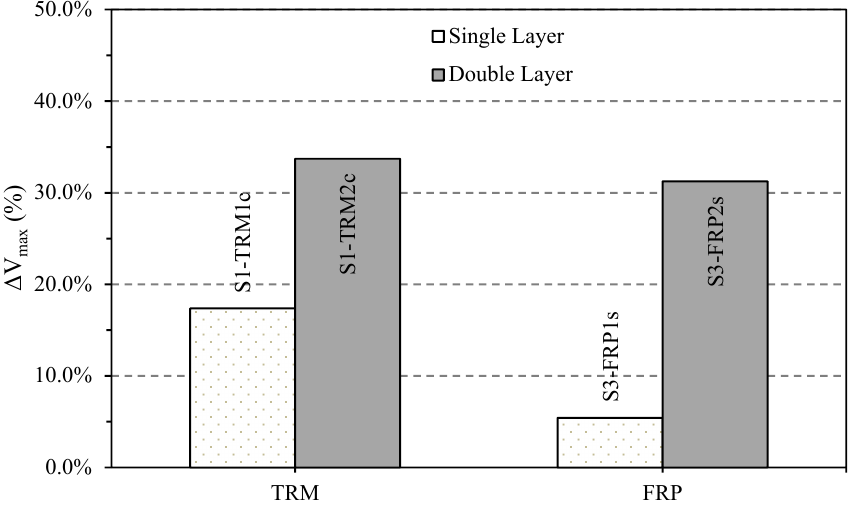
Figure 10. Effect of strengthening layers on shear-strengthening effectiveness.